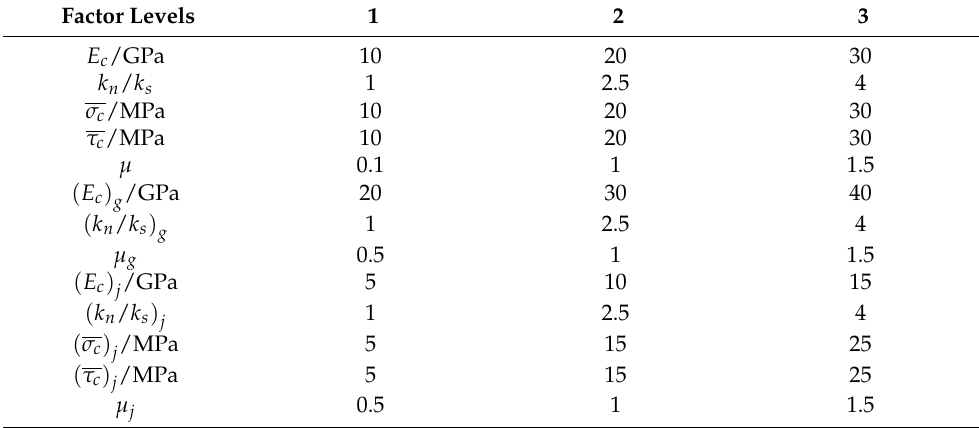
Table 5. Horizontal table of design factors of orthogonal